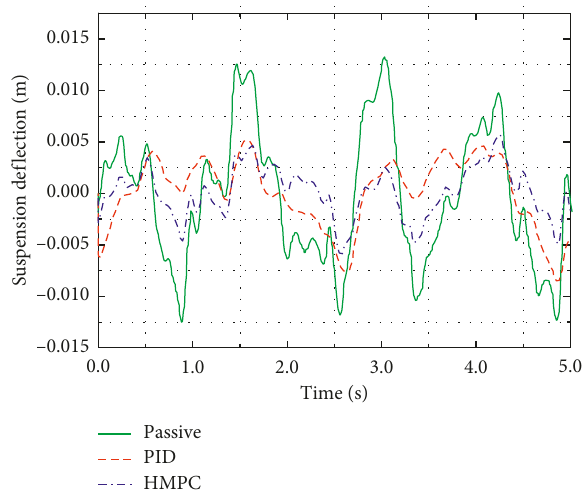
Figure 5: Vertical acceleration of the driver under bump input.